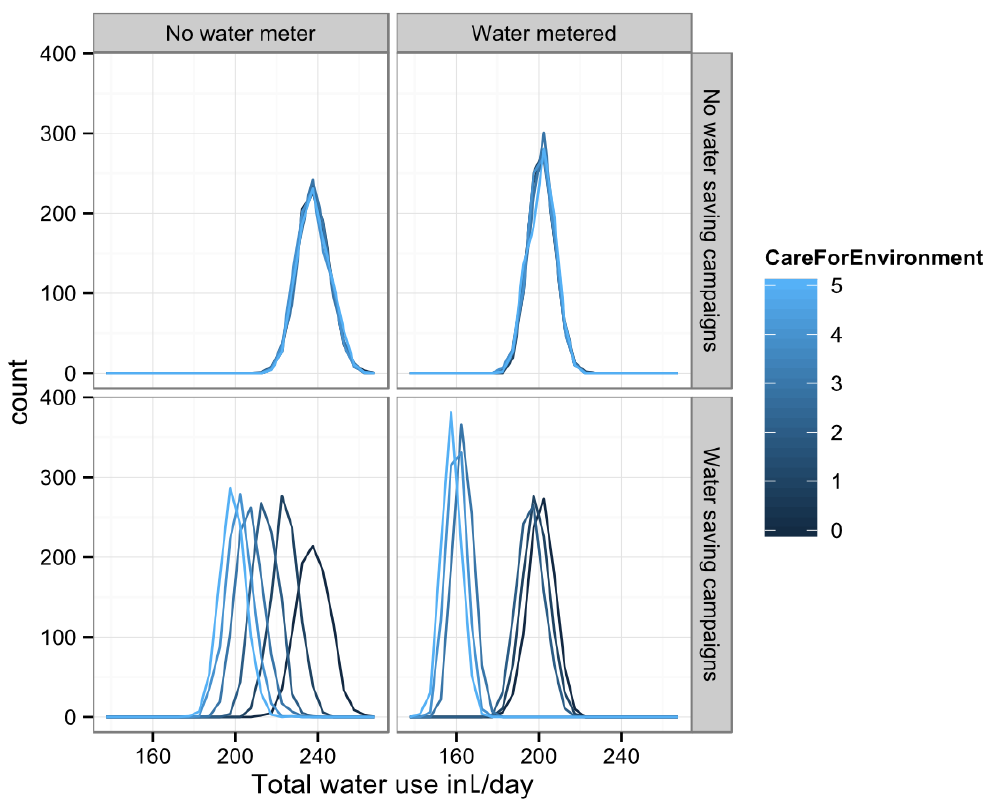
Figure 8. A density plot of a one-person household in USA home mean total